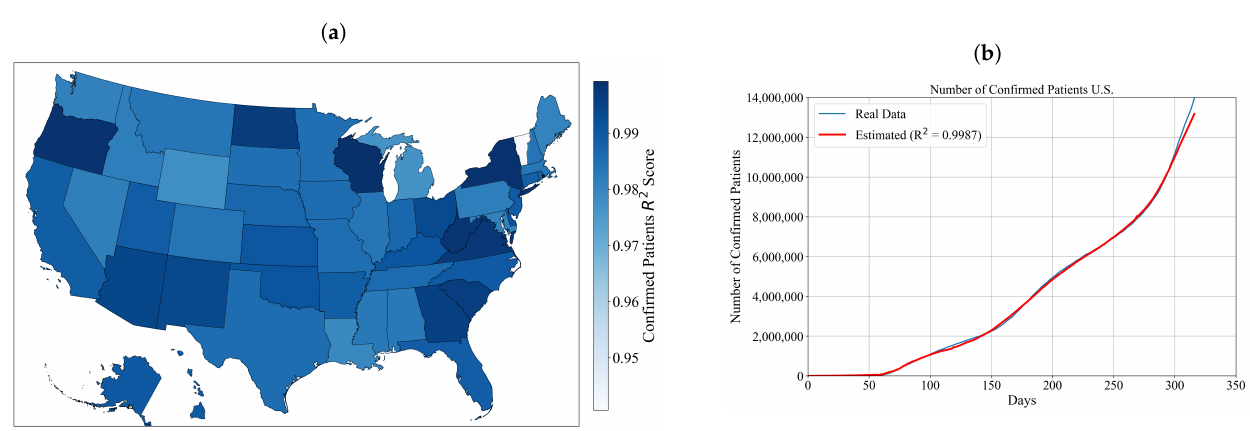
Figure 2. The obtained results for deceased patients: ( a ) the accuracy of obtained symbolic expressions used for estimation of number of confirmed patients for each state achieved on the testing dataset in terms of R 2 score; and ( b ) the comparison of estimated and actual numbers of confirmed patients through